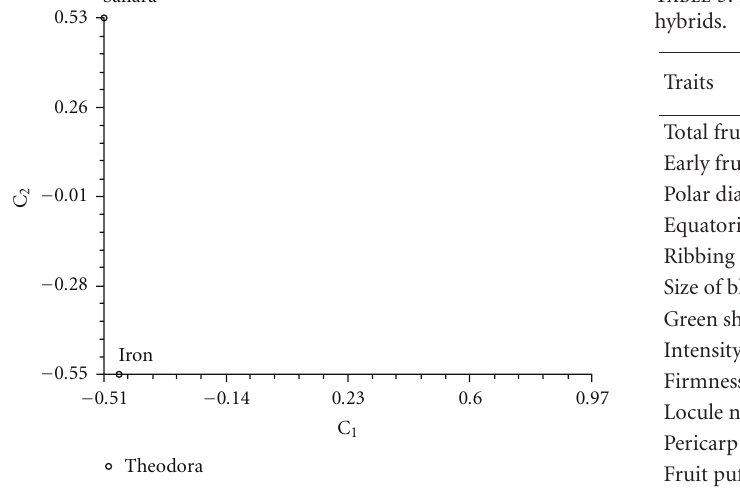
Figure 3: Two-dimensional plot based on correlation of each hybrid with the two principal components.